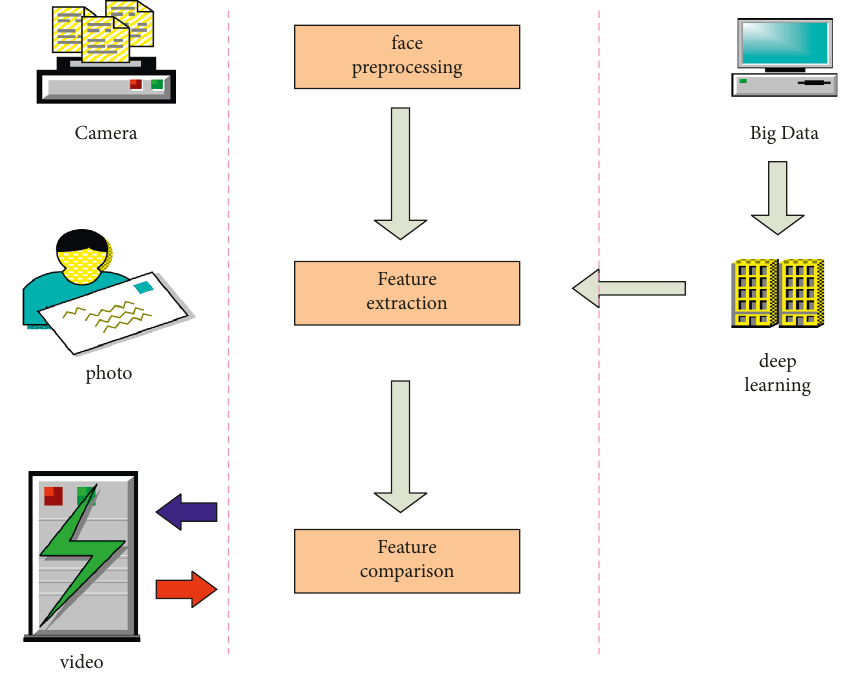
Figure 1: Facial expression recognition